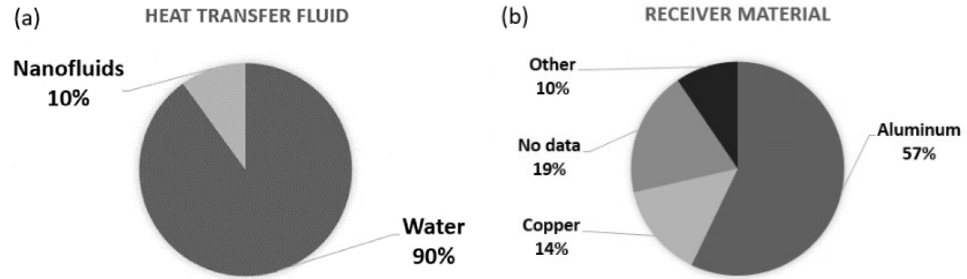
Figure 37. Pie chart showing the share of ( a ) HTF and ( b ) receiver material among papers regarding heat extraction devices with microscale channels.